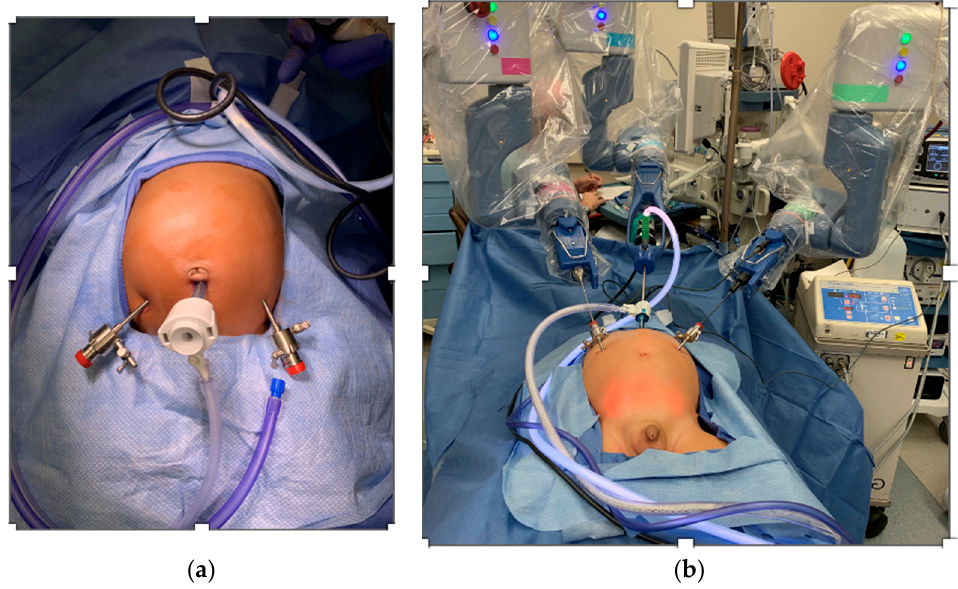
Figure 2. ( a ) Trocar placement in a 4-month-old infant with an abdominal cyst. ( b ) Trocar placement and Senhance set-up with 3 mm instruments in a 22-month-old infant with an undescended